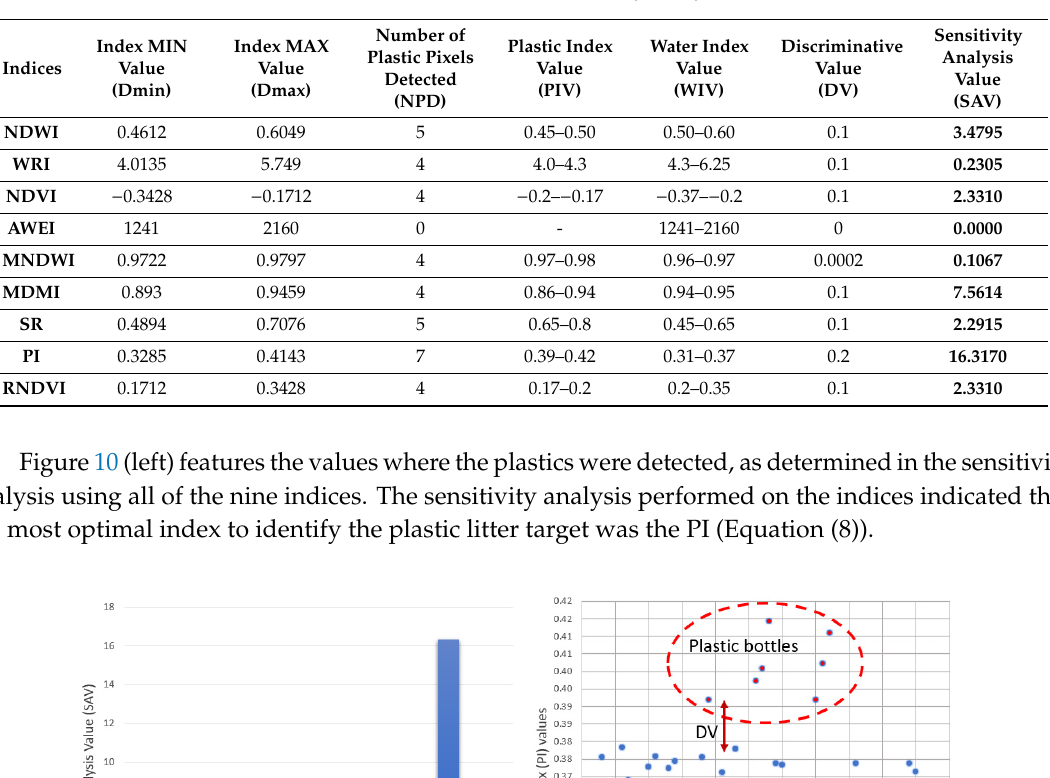
Table 2. Values used for sensitivity analysis.